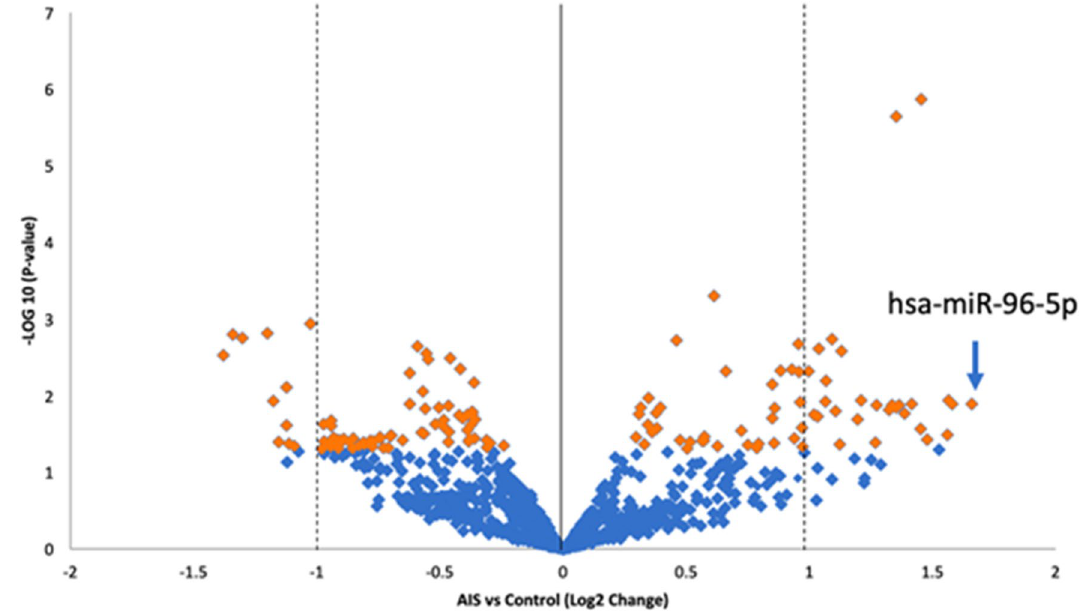
Figure 1. Differentially expressed miRNA candidates in iliac crest bone biopsies from